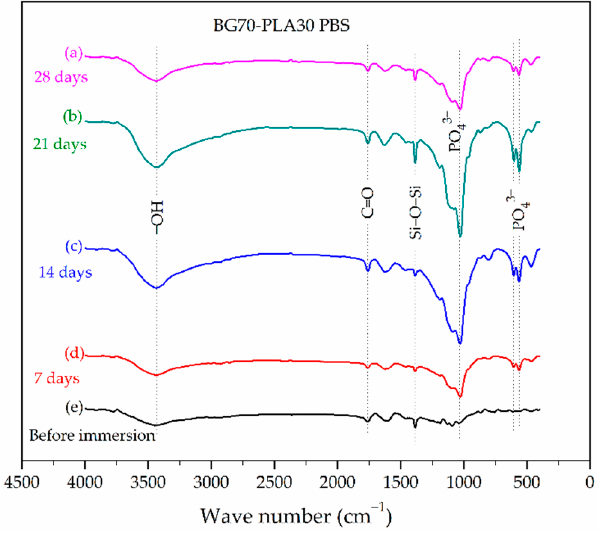
Figure 5. FTIR spectra of the BG70-PLA30 composite after different soaking times in PBS.